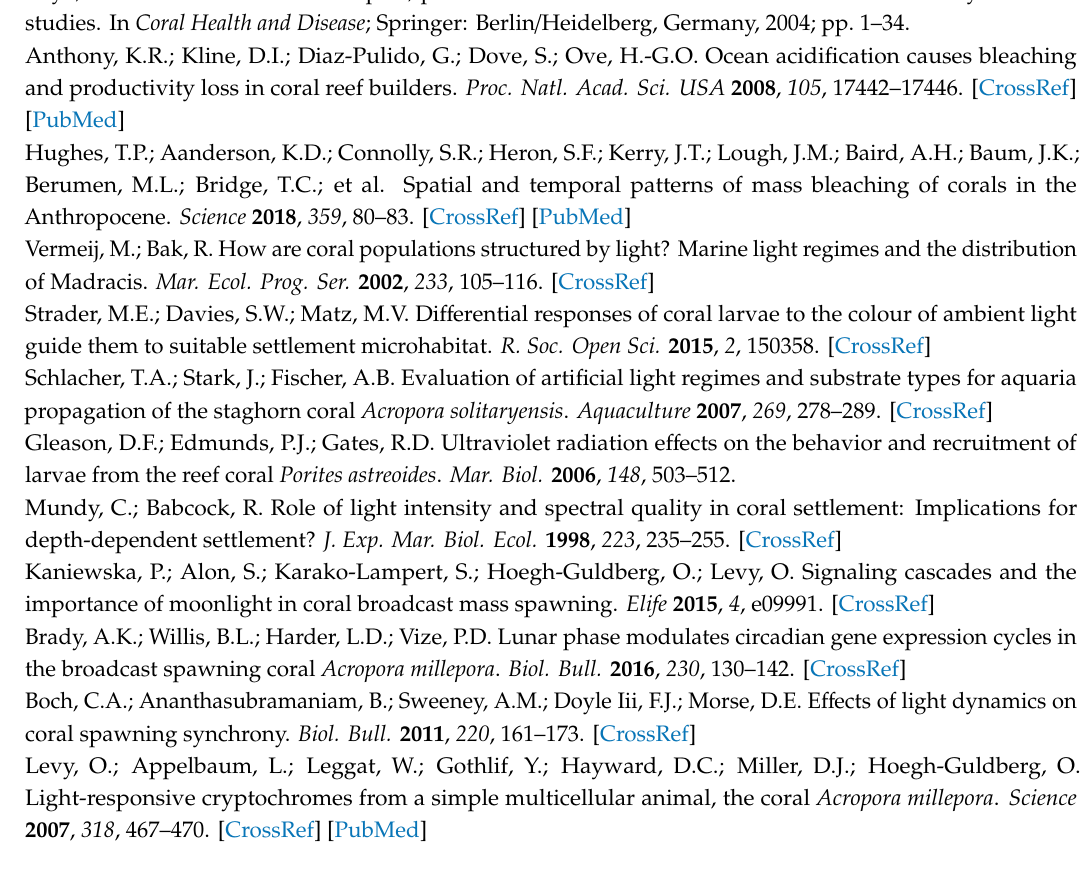
Figure S1: Multiyear temperature oscillations at the water tables setup. Table S1: Statistical values obtained for the settlement, survivorship, growth rate, calcification rate, net photosynthesis rate and PE (photosynthesis-energy) curve